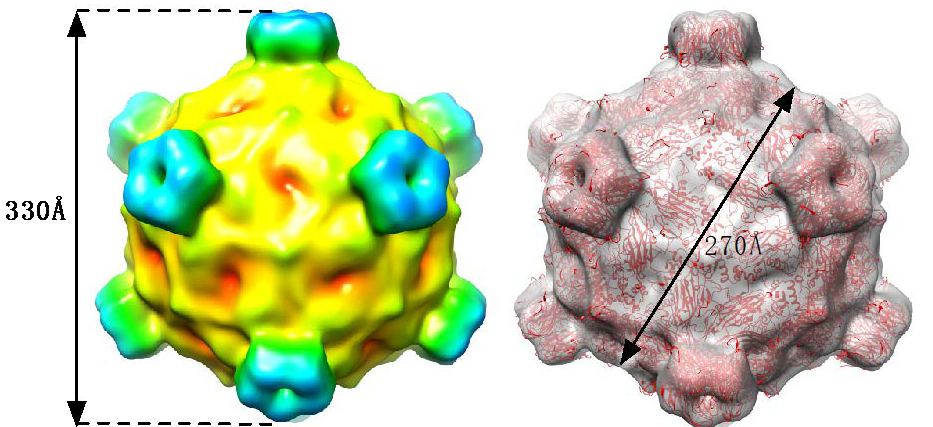
Figure 3. Cryo-EM structure of the purified phage. On the left is the 9.3 Å image reconstruction of the phage with the surface colored according to the radius. On the right is the image reconstruction with the structure of G4 [19] shown in the electron density envelope.